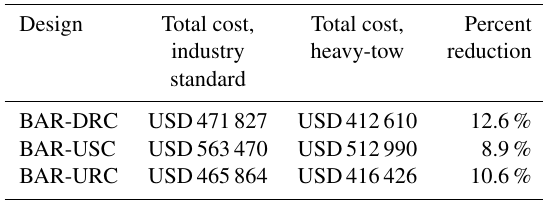
Table 8. Cost comparison of final blade designs using industry- standard carbon fiber composite spar caps vs. heavy-tow carbon fiber composite spar